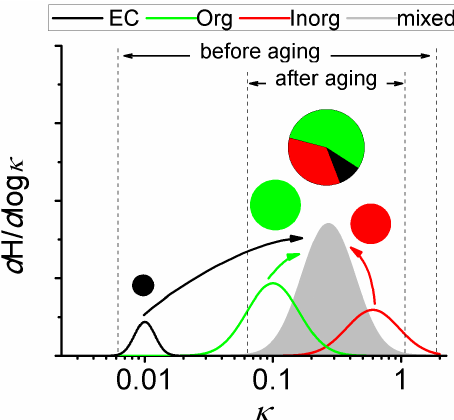
Fig. 1. Evolution of the mixing state and hygroscopicity ( κ ) in the aging process. Solid lines refer to d H/ dlog κ , the normalized number distributions of particle hygroscopicity. The areas of the pie diagrams refer to the abundance of individual chemical com- ponents (EC: elemental carbon, Org: organics, Inorg: inorganics). After aging, the externally mixed particles become internally mixed